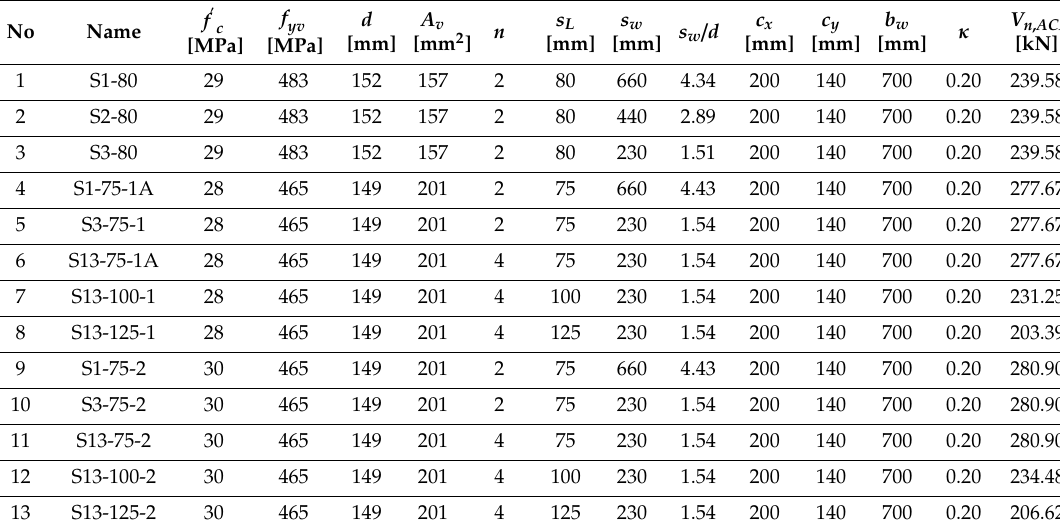
Table 5. Details of Shuraim’s